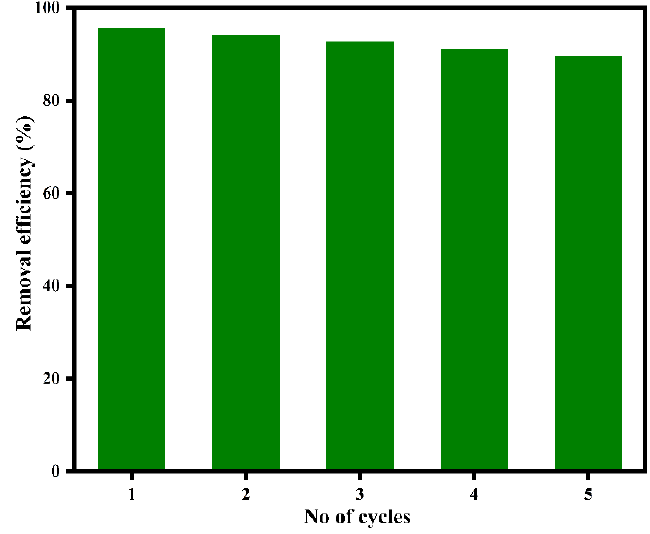
Figure 13. Reusability plot of agar/zeolite/CMC/PVA biomembrane.